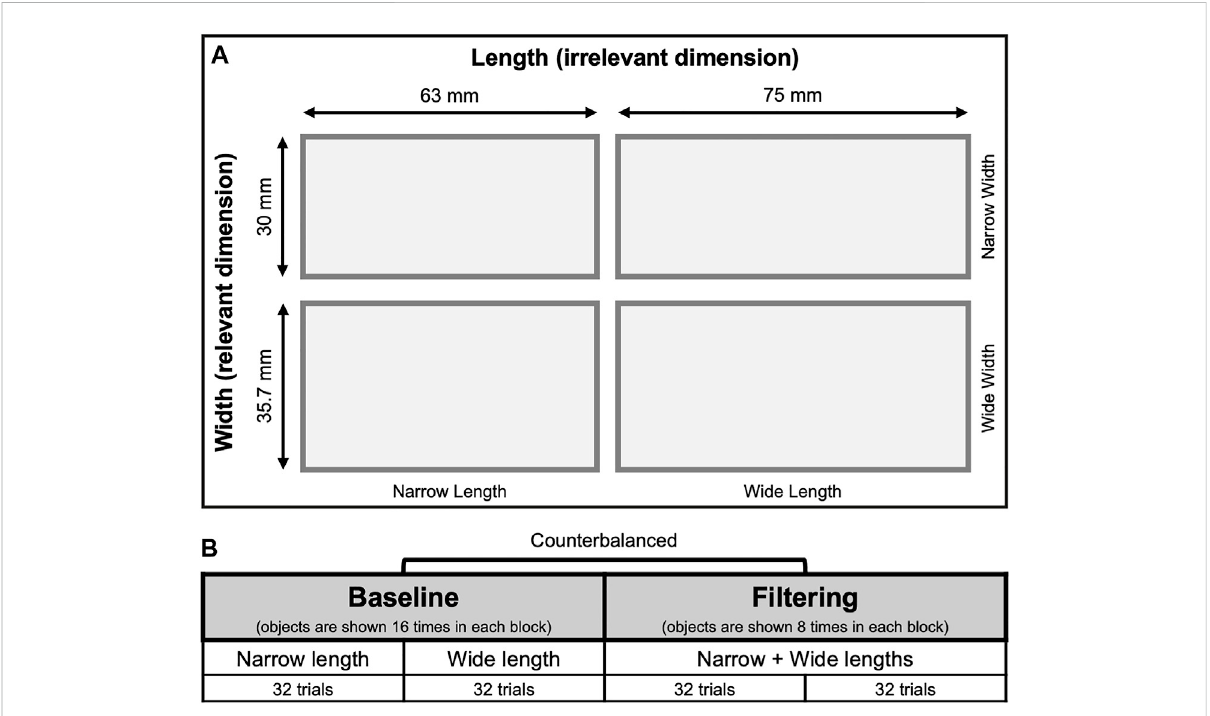
FIGURE 2 (A) The four virtual rectangular object dimensions were created from a factorial combination of two different widths (Narrow Width: 30 mm, Wide Width: 35.7 mm) and two different lengths (Narrow Length: 63 mm, Wide Length: 75 mm). Participants grasped objects along the width; therefore,thewidthisconsideredtherelevantdimensionwhilethelengthisconsideredtheirrelevantdimension. (B) Participantscompletedbaseline and fi ltering condition blocks, counterbalanced across participants. In the baseline condition, only the width varied across trials. In the fi ltering condition, both width and length varied across